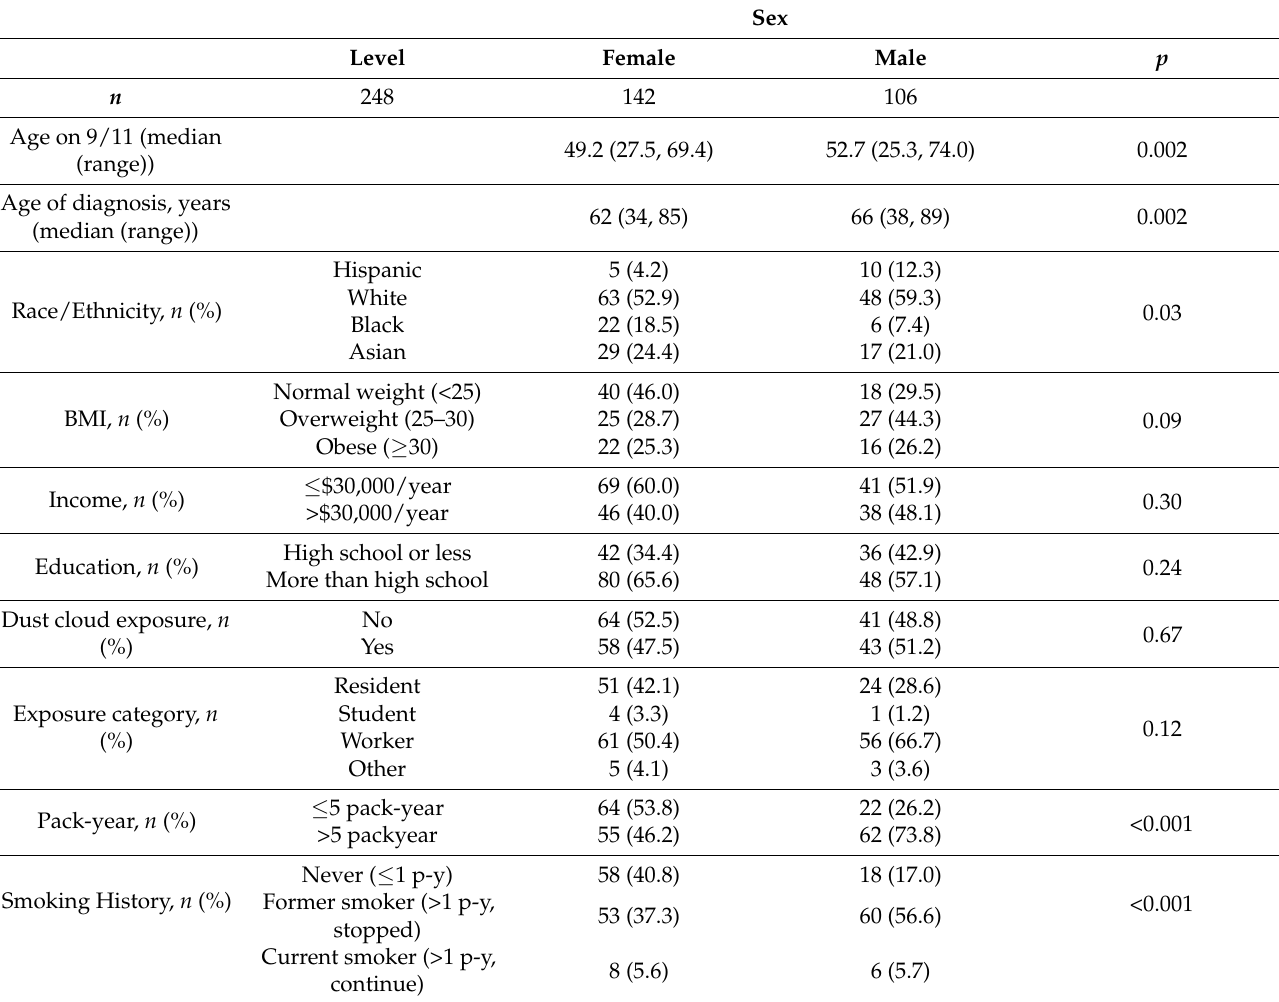
Table 3. Characteristics of lung cancer patients ( n = 248) classified by gender in the WTC